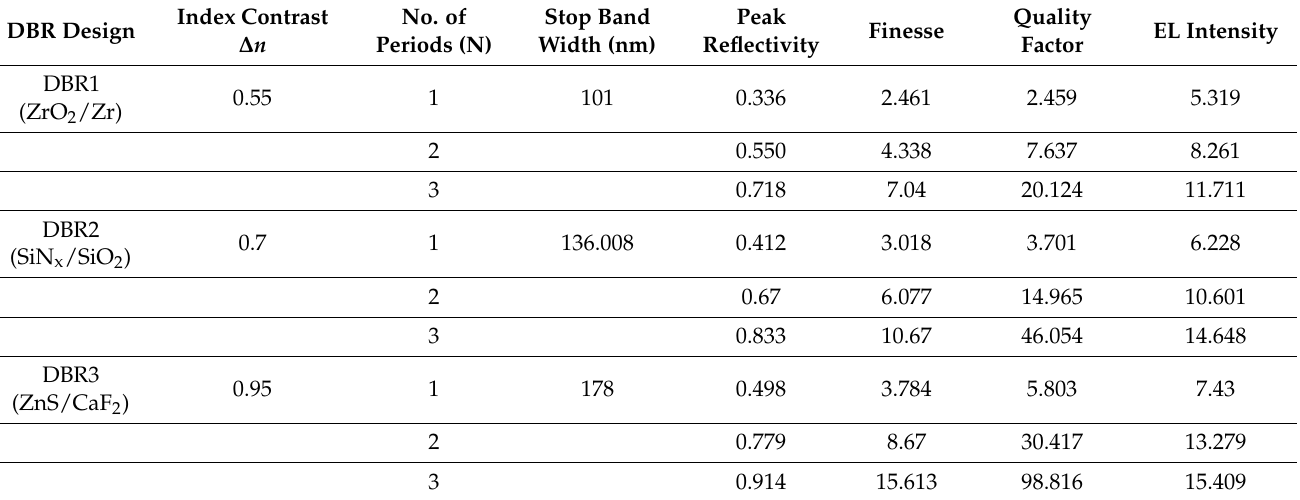
Table 2. Comparison of the main characteristics for devices based on different designs of DBRs at 550